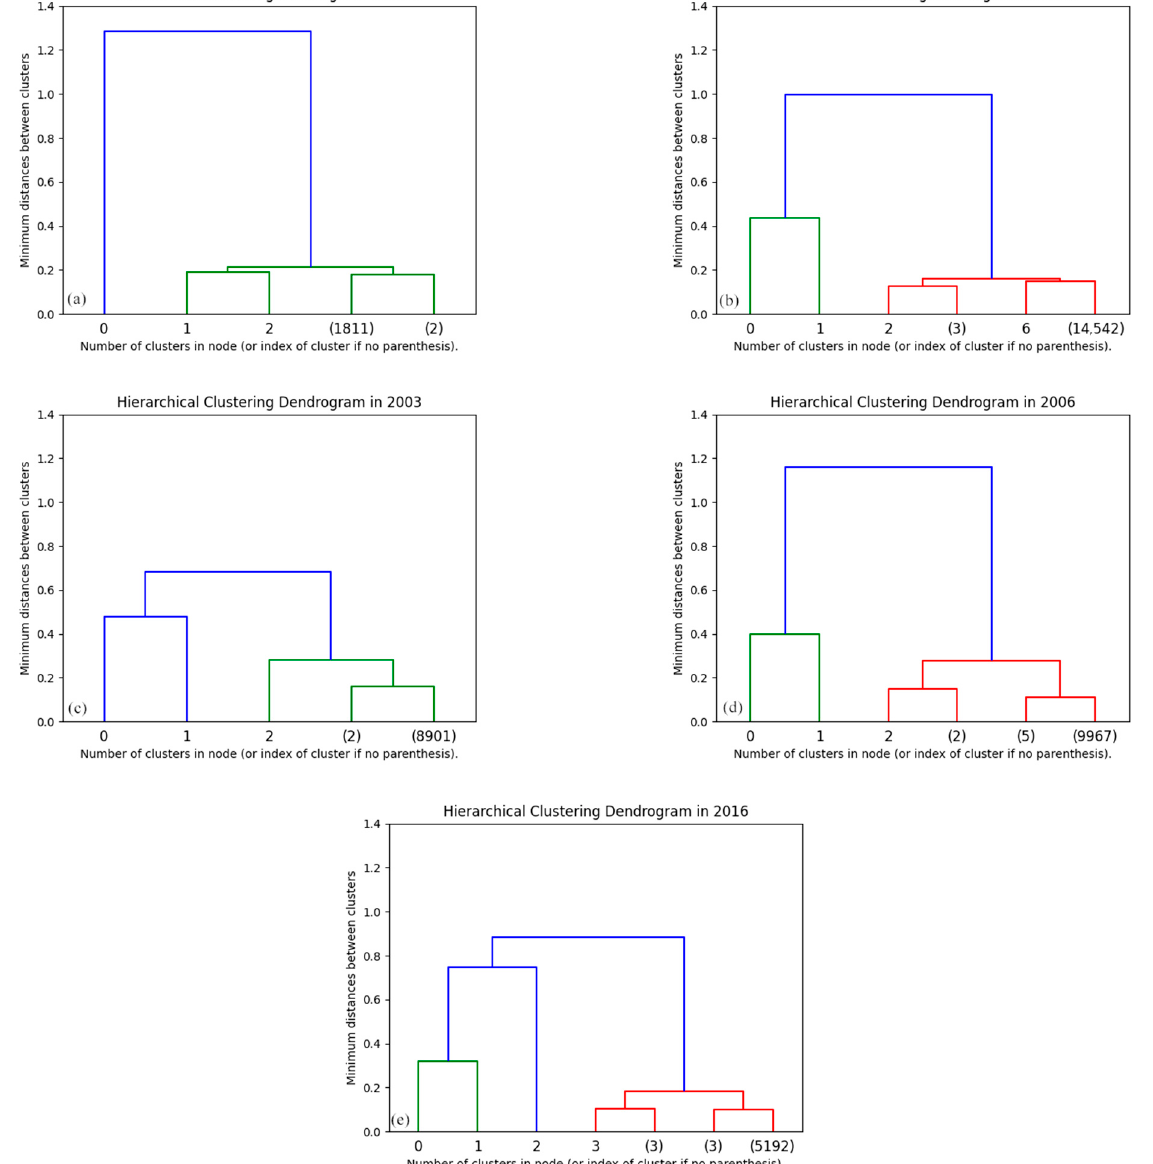
Figure 9. Results of hierarchical clustering dendrograms ( a – e ) from 1994 to 2016. The identified urban boundaries for five years are shown in Figure 10. The results of the qualitative analysis can be summarized as follows: (1) In 1994, built-up land clus- ters near the east and the west of Huangpu River merged into one large morphological agglomeration because of the long threshold radius of 140 m. Such a scope just conforms to the initial central urban area in Shanghai, which includes most of the range of Huangpu, Hongkou, Yangpu, Jingan, Putuo, Changning, and Xuhui, the east region of Baoshan and a small region in the northwest of Pudong. (2) In 2000, built-up land was separated into east and west regions by the Huangpu River, and the west area was larger than the east area, which corresponded to their development levels. In the west, the urban area sprawled over most of Minhang west of the Huangpu River and the middle area of Baoshan. In the east, the urban area rapidly covered the west part of Pudong, which illustrates the rapid development in Pudong in the late 1990s. (3) In 2003, the urban area in the east and west regions showed a striking contrast: the urban area in the west region grew quickly and began to invade Jiading and Songjiang, much more quickly than the east